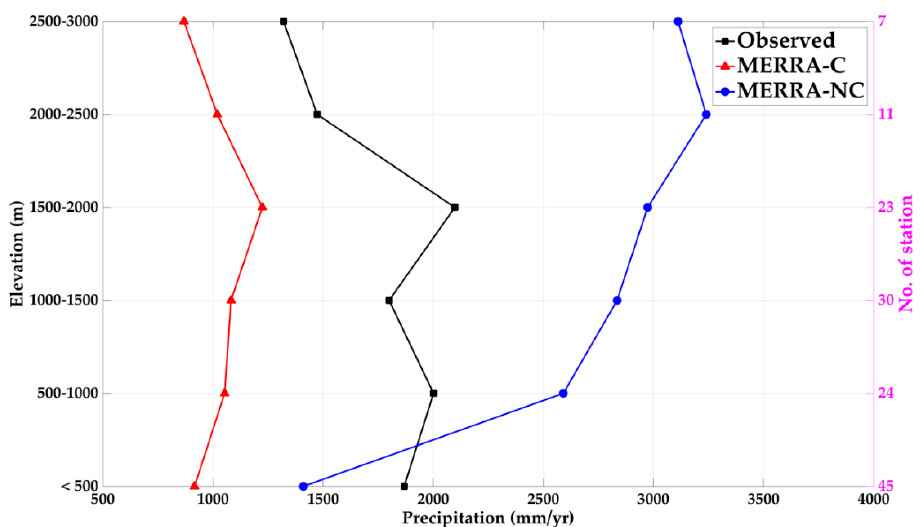
Figure 10. Mean annual precipitation in observed and MERRA-2 datasets at different elevation range with a respective number of the station during the study period.